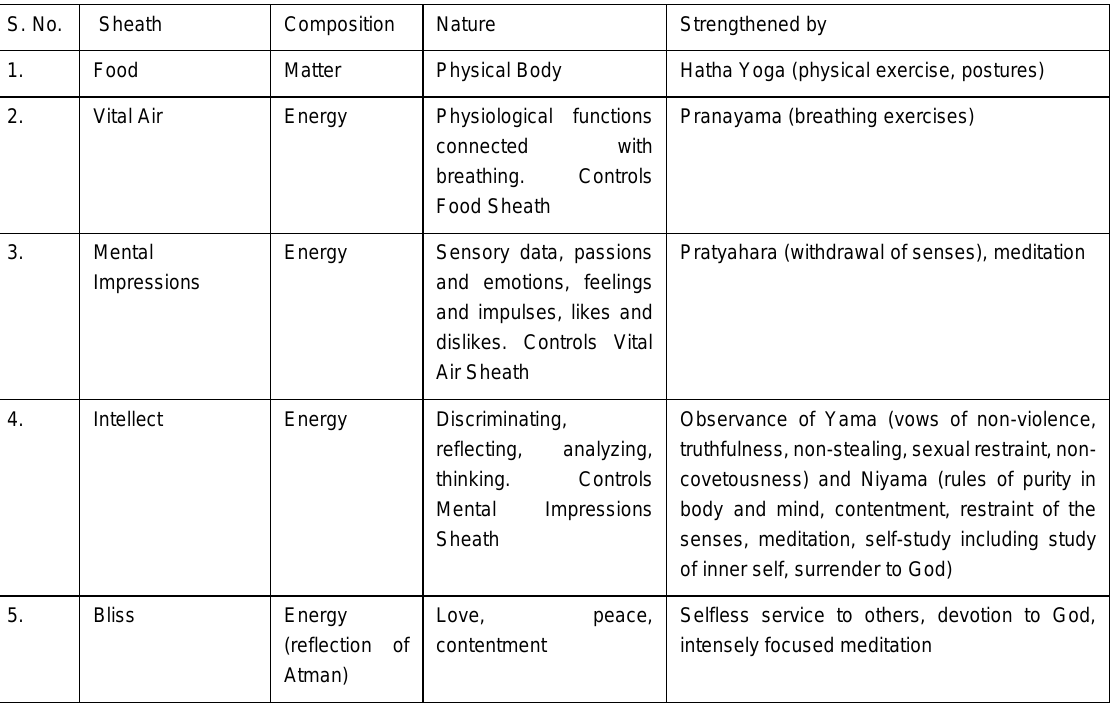
Table 1: Attributes of the Five